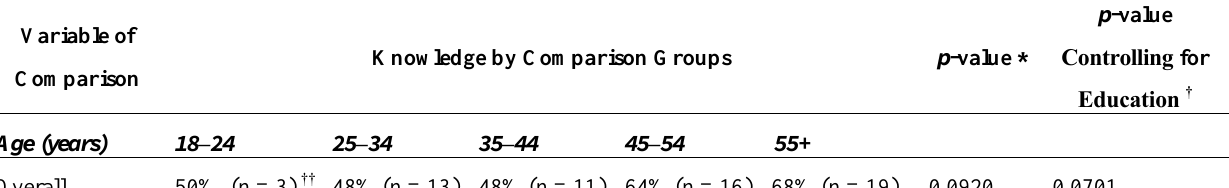
Table 2. Group differences in knowledge of the term “fish consumption advisory” for the overall sample of study participants at Badin Lake, NC, USA compared to a subsample that shares fish caught with women and